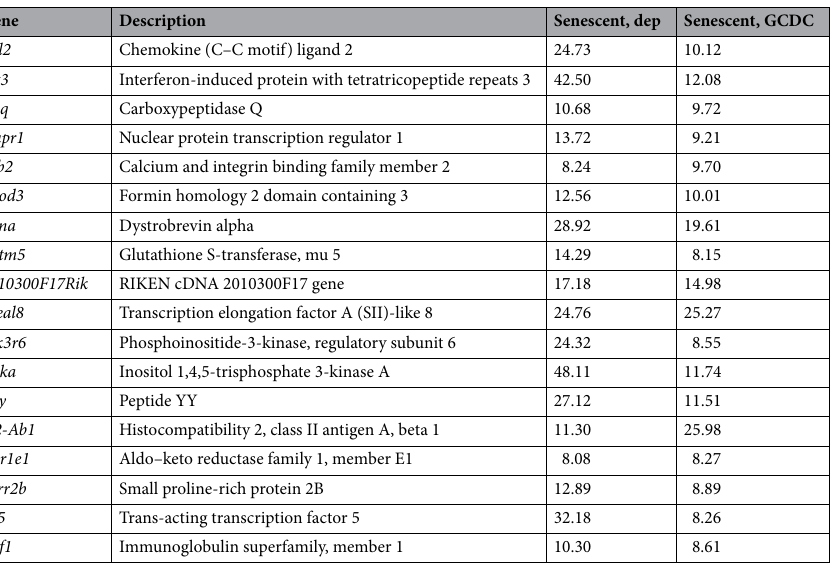
Table 1. Genes upregulated in senescent biliary epithelial cells (BECs) induced by GCDC treatment ant serum depletion. The fold difference was obtained by dividing the mRNA level in senescent BECs with that in control BECs. Dep serum depletion, GCDC glycochenodeoxycholic acid (detail data are shown in Supplemental Table